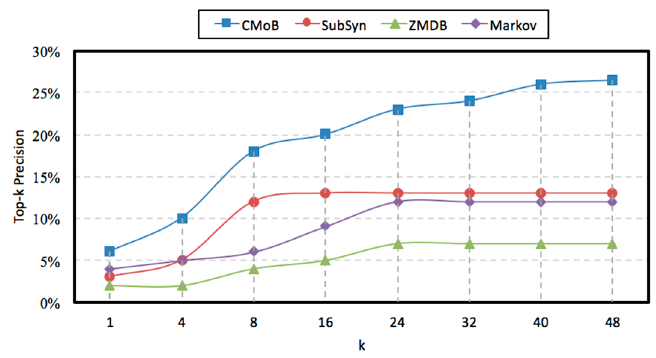
Figure 15. Top- k Precision with different k.